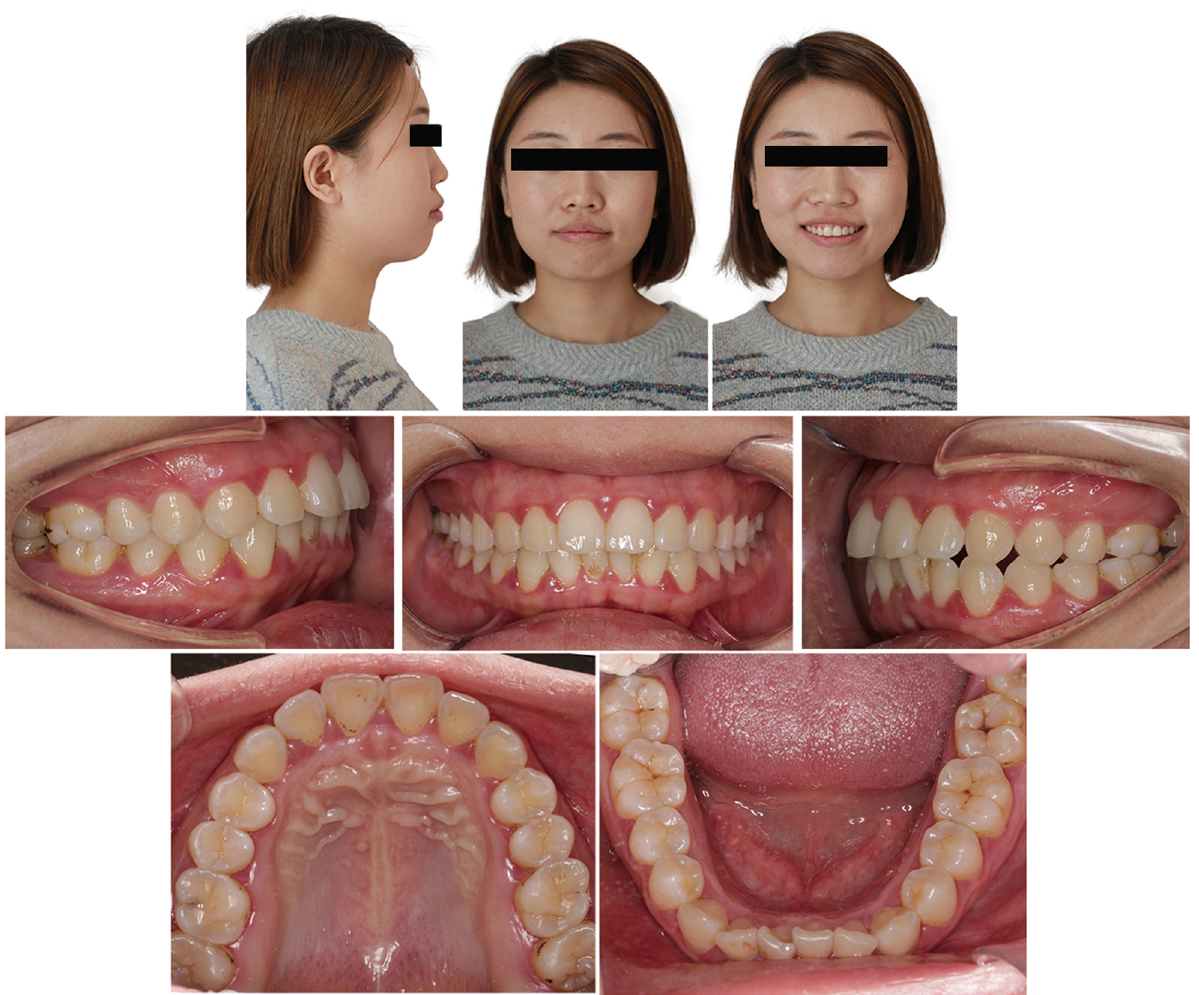
Figure 1. Pretreatment facial and intraoral